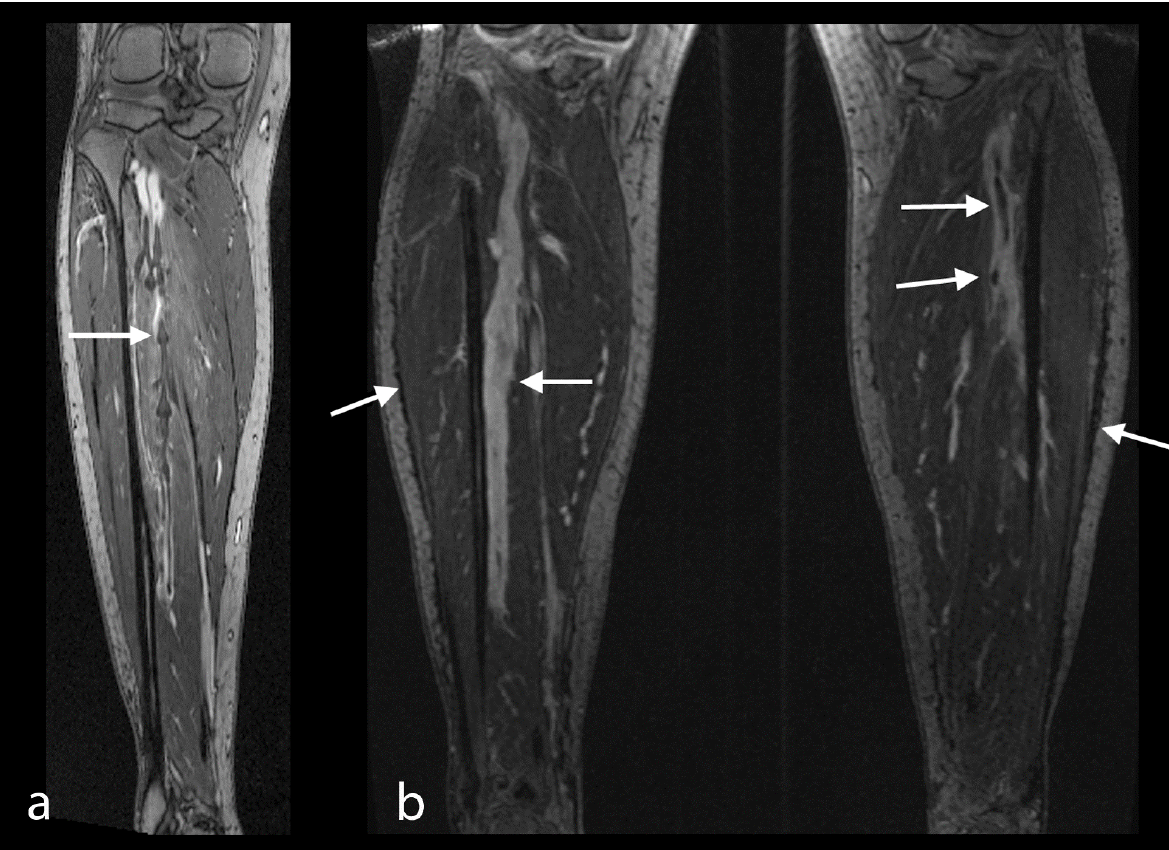
Figure 5. ( a ) MRV in a 26-year-old female patient. Recent thrombi in the right fibular veins, with partial obstruction in the distal segment of the popliteal vein. Excellent delineation of valves. Excellent examination quality; ( b ) MRV in a 44-year-old female patient. Minor PE after long distance flight. Left leg: filling defect representing acute thrombi in the distal popliteal and proximal fibular vein (see arrow). Right leg: venous wall irregularities, luminal inhomogeneities with destroyed venous valves, representing post-thrombotic changes (see upper arrows). Both legs: small subcutaneous fluid collections with global leg swelling (see arrows). Excellent examination quality.